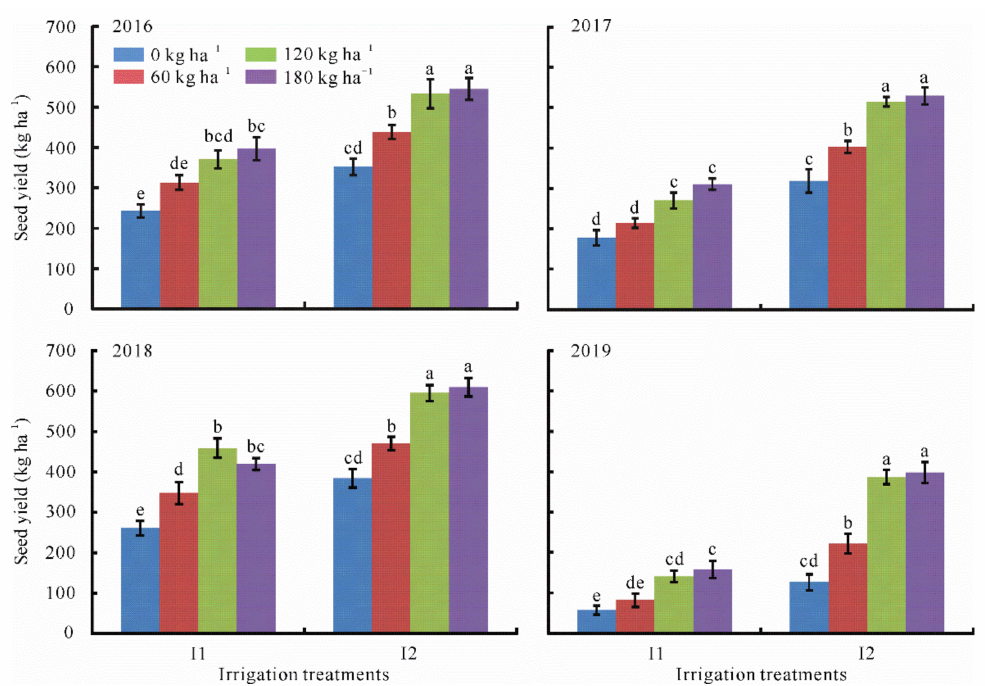
Figure 2. Effects of different irrigation and nitrogen rate treatments on Cleistogenes songorica seed yield from 2016 to 2019. Bars represent the standard errors ( n = 3). Different lowercase letters above bars within a year indicate significant difference at p < 0.05 level. I1: watering at tillering stage, a total of 50 mm water was added in each year; I2: watering at tillering, spikelet initiation, and early flowering stages, respectively, a total of 150 mm water was added in each